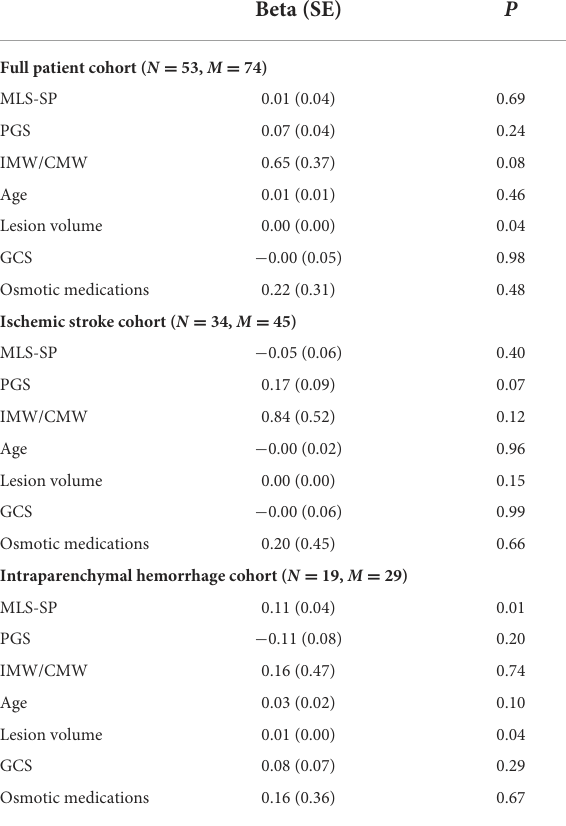
TABLE 3 Multivariable model assessing Diff NPi and radiographic markers of midline